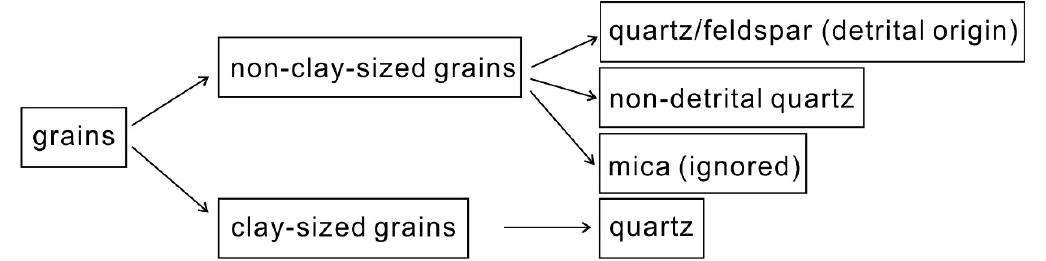
Figure 4. Flowchart of grain classification, modified after [31].